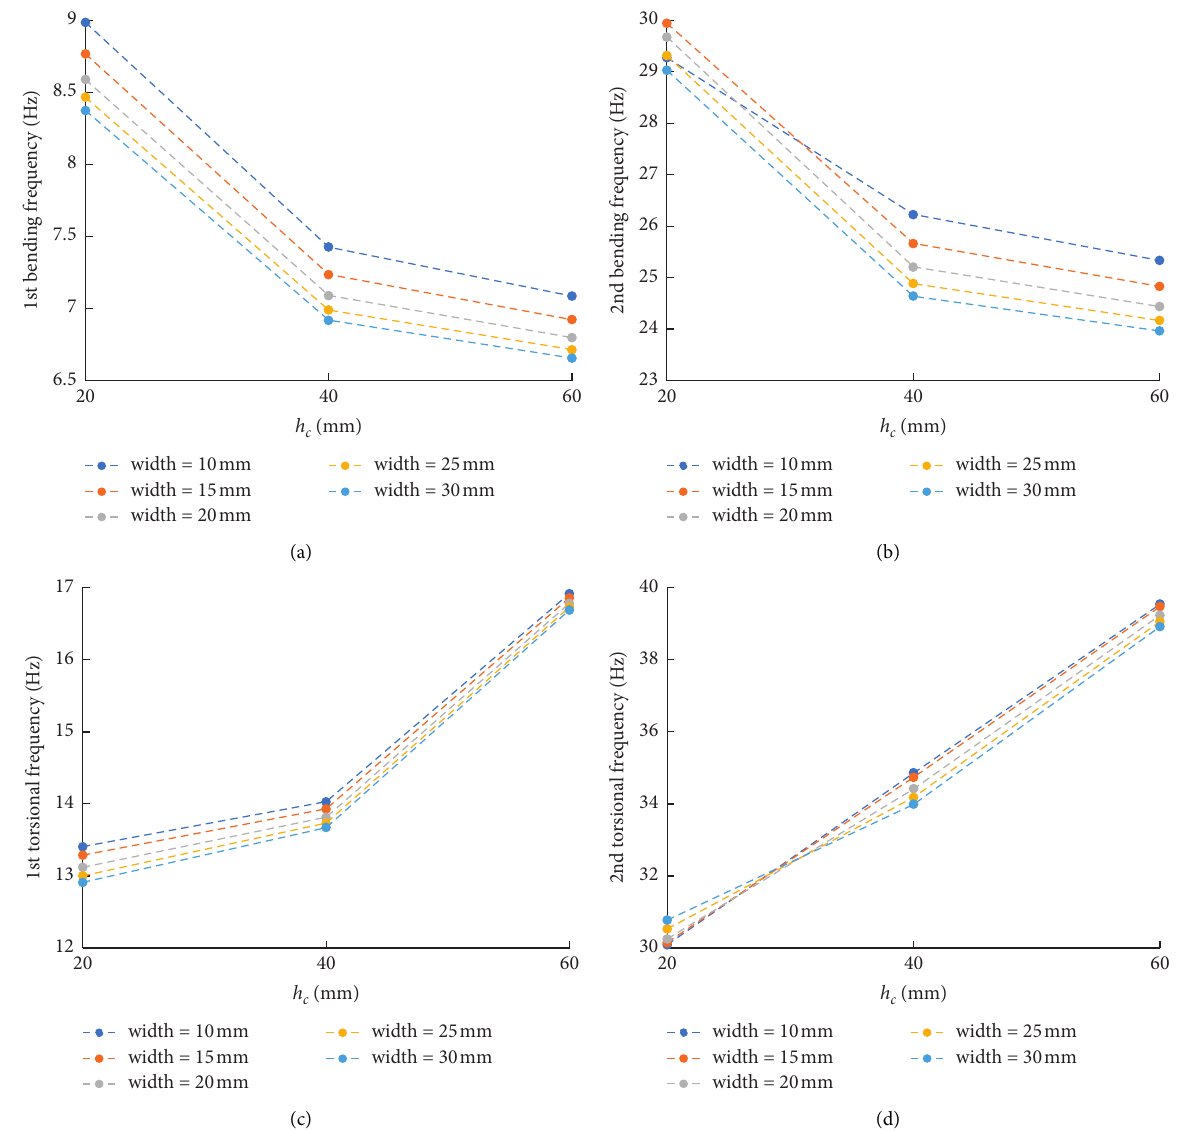
Figure 14: Natural vibration frequencies with h